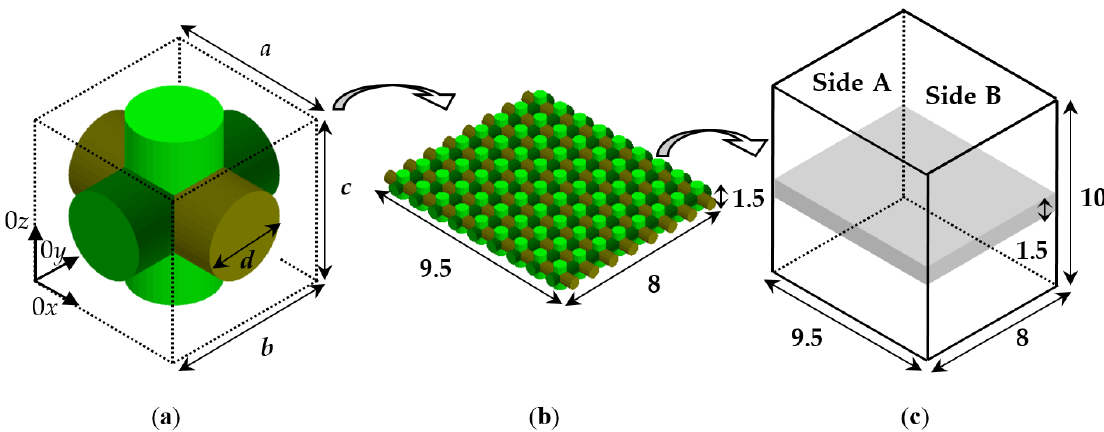
Figure 3. ( a ) Unit cell a × b × c with cylindrical threads of diameter d ; ( b ) constructed artificial sample with repeated unit cells in a hosting isotropic substrate (air); ( c ) equivalent sample in a rectangular box, which is a quarter part of the whole resonator with symmetrical boundary conditions on Side A and B.